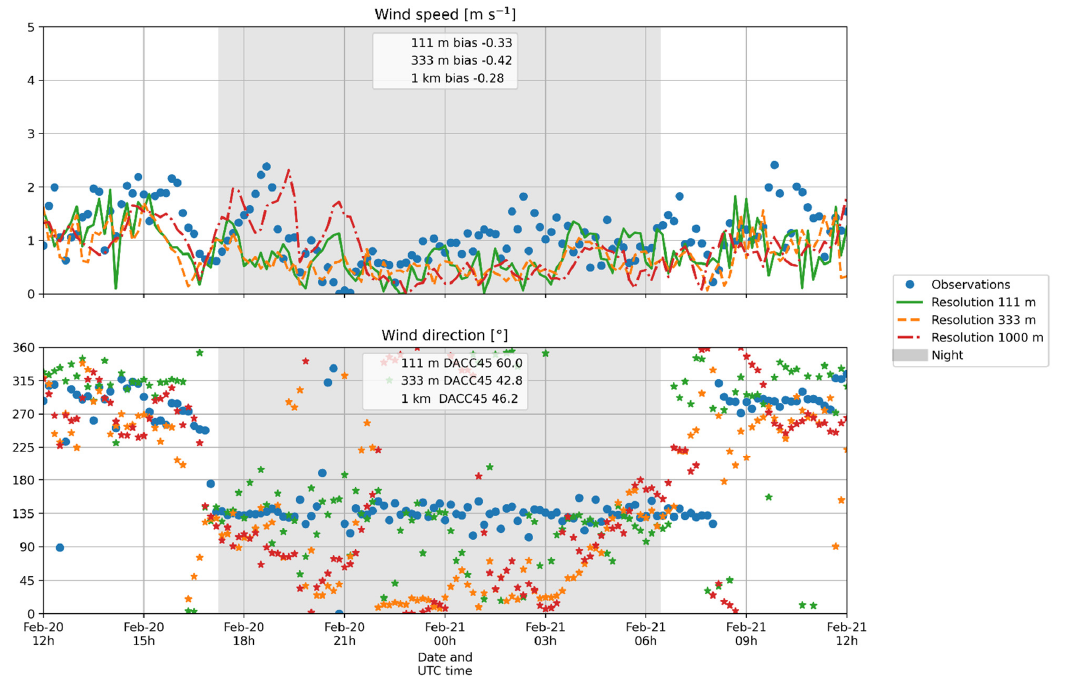
Figure 6. Performance of the model in simulating wind speed (top) and direction (bottom) at MET01 for different resolutions of the finest domain. The blue dots are observations, whereas the red, orange, and green lines (dots) represent the simulated wind speed (direction) for the 1000, 333, and 111 m resolutions, respectively. The shaded area represents nighttime. The average bias on the wind speed (in m s − 1 ) and the direction accuracy (DACC45, in %) are indicated on the plots for the three resolutions.